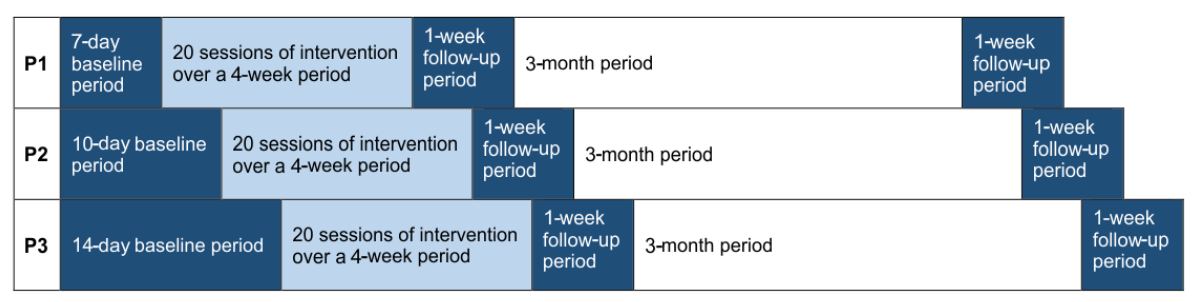
Figure 1. Study procedure. Each participant (P1-3) will be randomly allocated to 1 of 3 baseline periods. Each baseline phase will be followed by 20 days of a brain-computer interface (BCI)-based neuromodulative intervention over a 4-week period, and there will be a 1-week follow-up period for all participants. A further 1-week follow-up will take place 3 months after completion of the intervention.